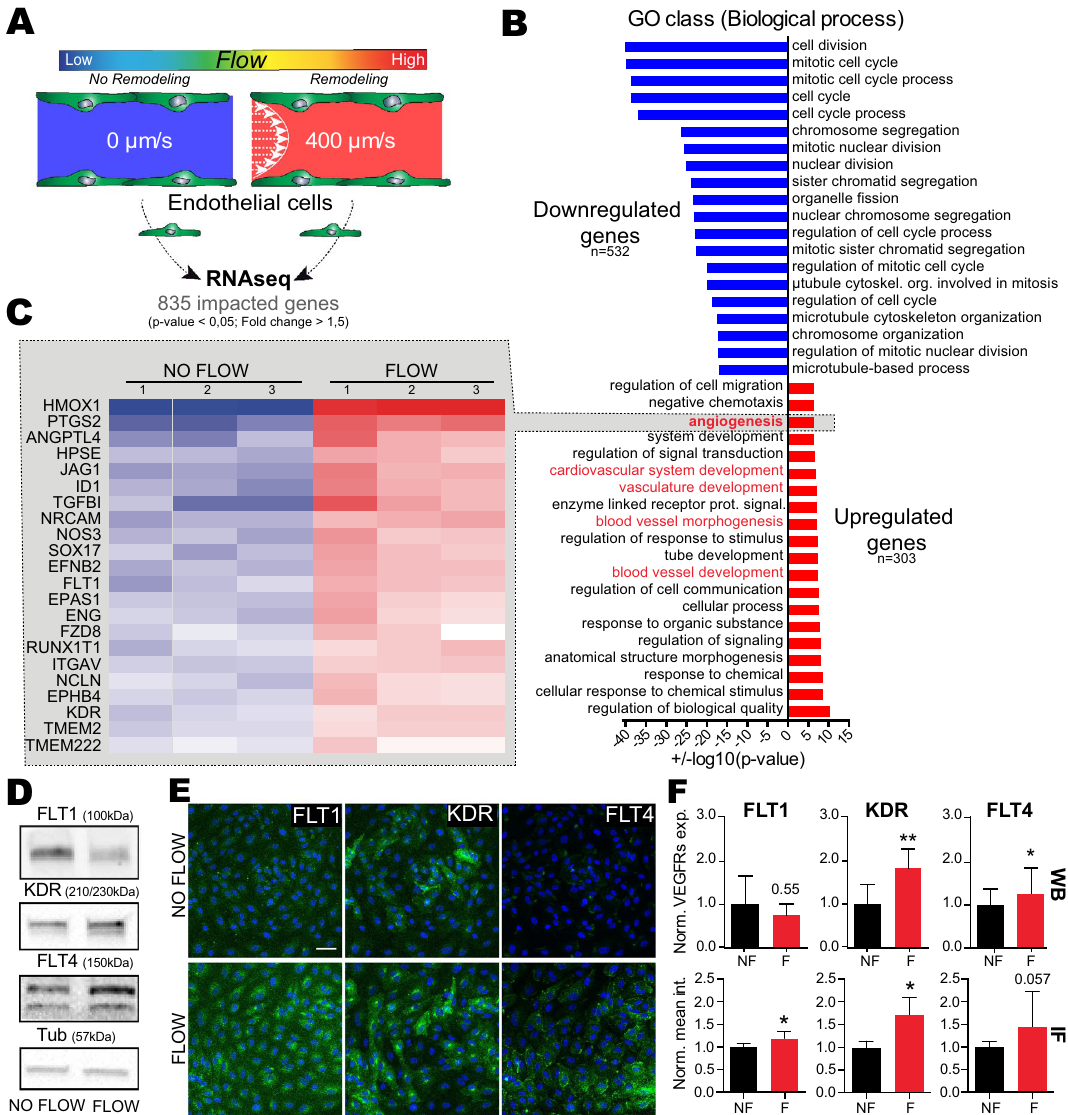
Figure 1. Flow favors expression of gene program driving vasculature remodeling, including VEGFRs. (A) Experimental setup: microfluidic experiment for RNA sequencing. ( B) Results from global Gene Ontology (GO) analysis on ‘biological process’, showing most significantly impacted GO class. ( C) Fold changes heatmap, based on GO class: Angiogenesis, showing significantly upregulated genes in flow condition compared to no flow. ( D) Western blot quantification validating some of VEGFR RNAseq data. ( E) Representative image of flow vs no flow immunofluorescence labelling of FLT1, KDR and FLT4 (green) with DAPI (blue). ( F) Quantification associated with D and E, showing increased expression and signal intensity of VEGFRs. WB: N = 5, Mann Whitney test, IF: N = 4 with min 5 fields/exp, Mann Whitney